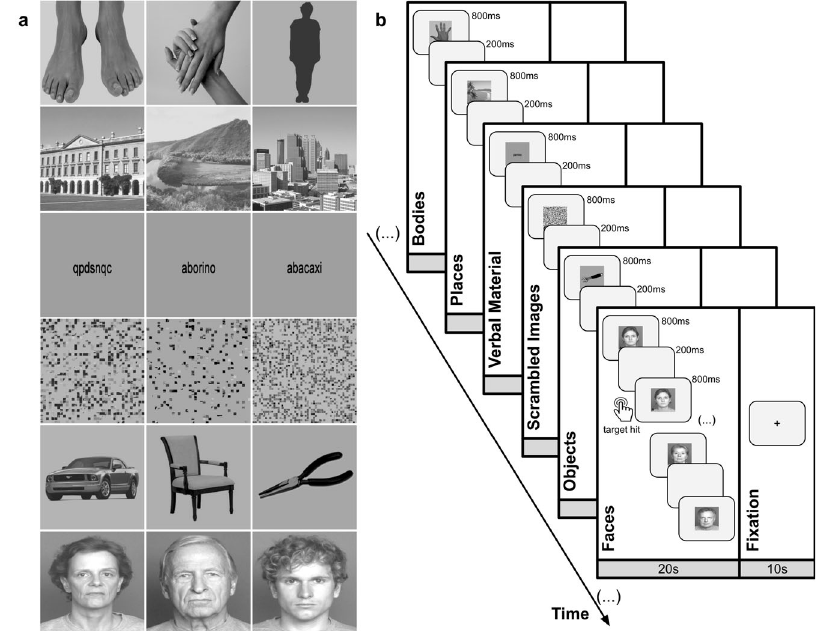
Fig. 4 Task-driven functional mapping of PCC. a fMRI task design, a total of 6 visual stimulus types were presented. Each run comprised 18 pseudo- randomized blocks with 3 blocks per category of objects. Each block was composed of 20 images, each one presented for ~800 ms followed by a ~200 ms of interstimulus interval which represents an individual duration of 20 s per block. Each block was separated by 10-s fi xation. Subjects performed a 1-back task, being instructed to press a button every time the image being presented was the same that had been presented immediately before. b Sample images from different categories used on the fMRI task. Faces stimuli were taken from the FACES database; Bodies stimuli were selected from Bochum Emotional Stimulus Set database and Place stimuli were available on the Computational Visual Cognition Laboratory. c Behavioural metrics, dprime and reaction times (RT), obtained for both AD and controls in the functional task.